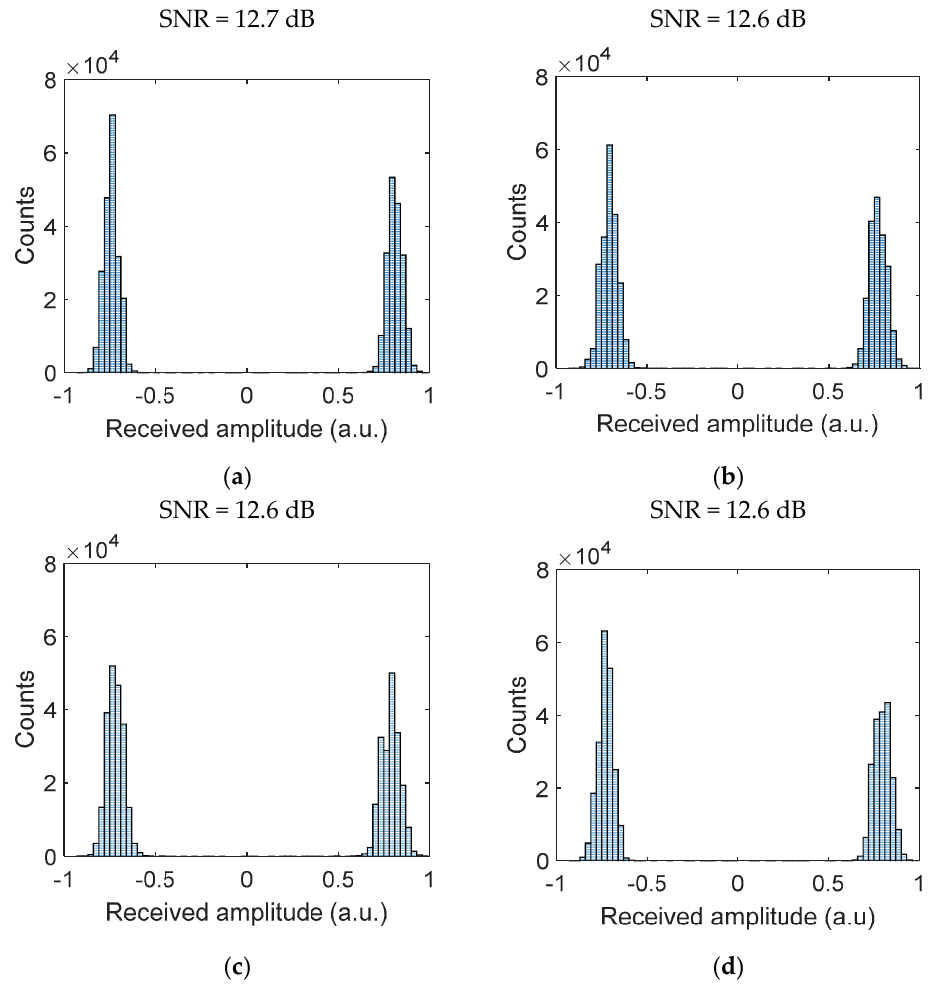
Figure 8. PD Rx histogram plot for ( a ) a clear channel and channels with AT conditions of ( b ) 𝐶 (cid:3041)(cid:2870) = 3.9 × 10 (cid:2879)(cid:2869)(cid:2869) m (cid:2879)(cid:2870) (cid:2871)⁄ , ( c ) 𝐶 (cid:3041)(cid:2870) = 7.9 × 10 (cid:2879)(cid:2869)(cid:2869) m (cid:2879)(cid:2870) (cid:2871)⁄ , and ( d ) 𝐶 (cid:3041)(cid:2870) = 1.0 × 10 (cid:2879)(cid:2869)(cid:2868) m (cid:2879)(cid:2870) (cid:2871)⁄ . 3.9 × 10 − 11 m − 2/3 , ( c ) C 2 n = 7.9 × 10 − 11 m − 2/3 , and ( d ) C 2 n = 1.0 × 10 − 10 m − 2/3